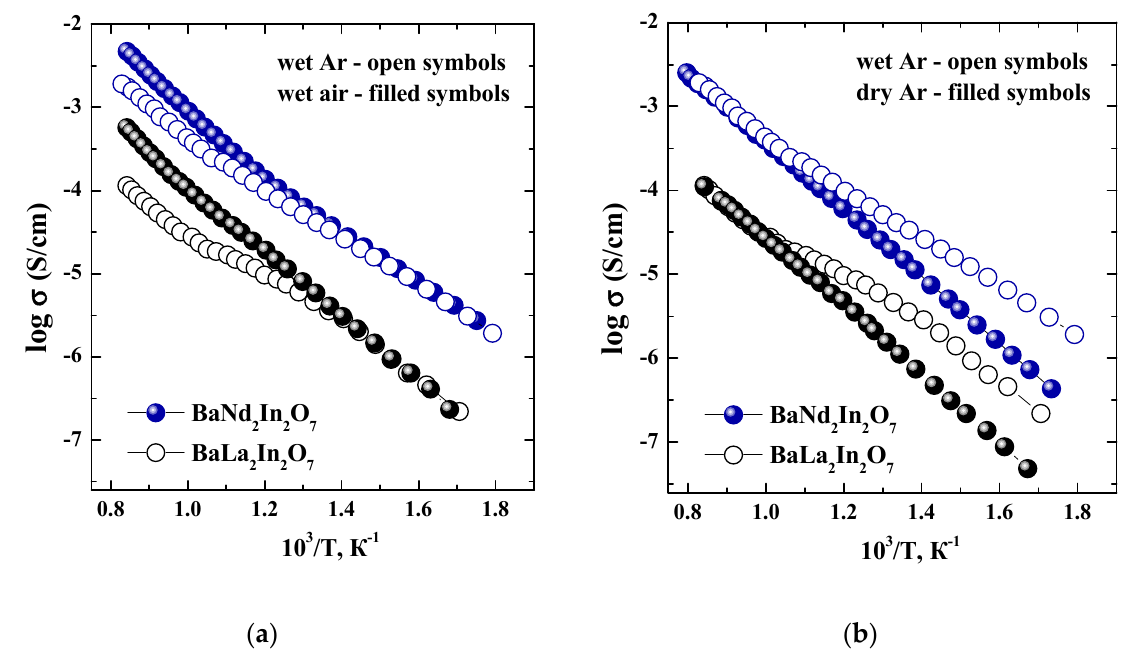
Figure 7. Temperature dependencies of conductivity for BaNd 2 In 2 O 7 (blue symbols) and BaLa 2 In 2 O 7 (black symbols) [17] obtained at wet Ar (open symbols) and wet air (filled symbols) ( a ); wet Ar (open symbols) and dry Ar (filled symbols) ( b ).